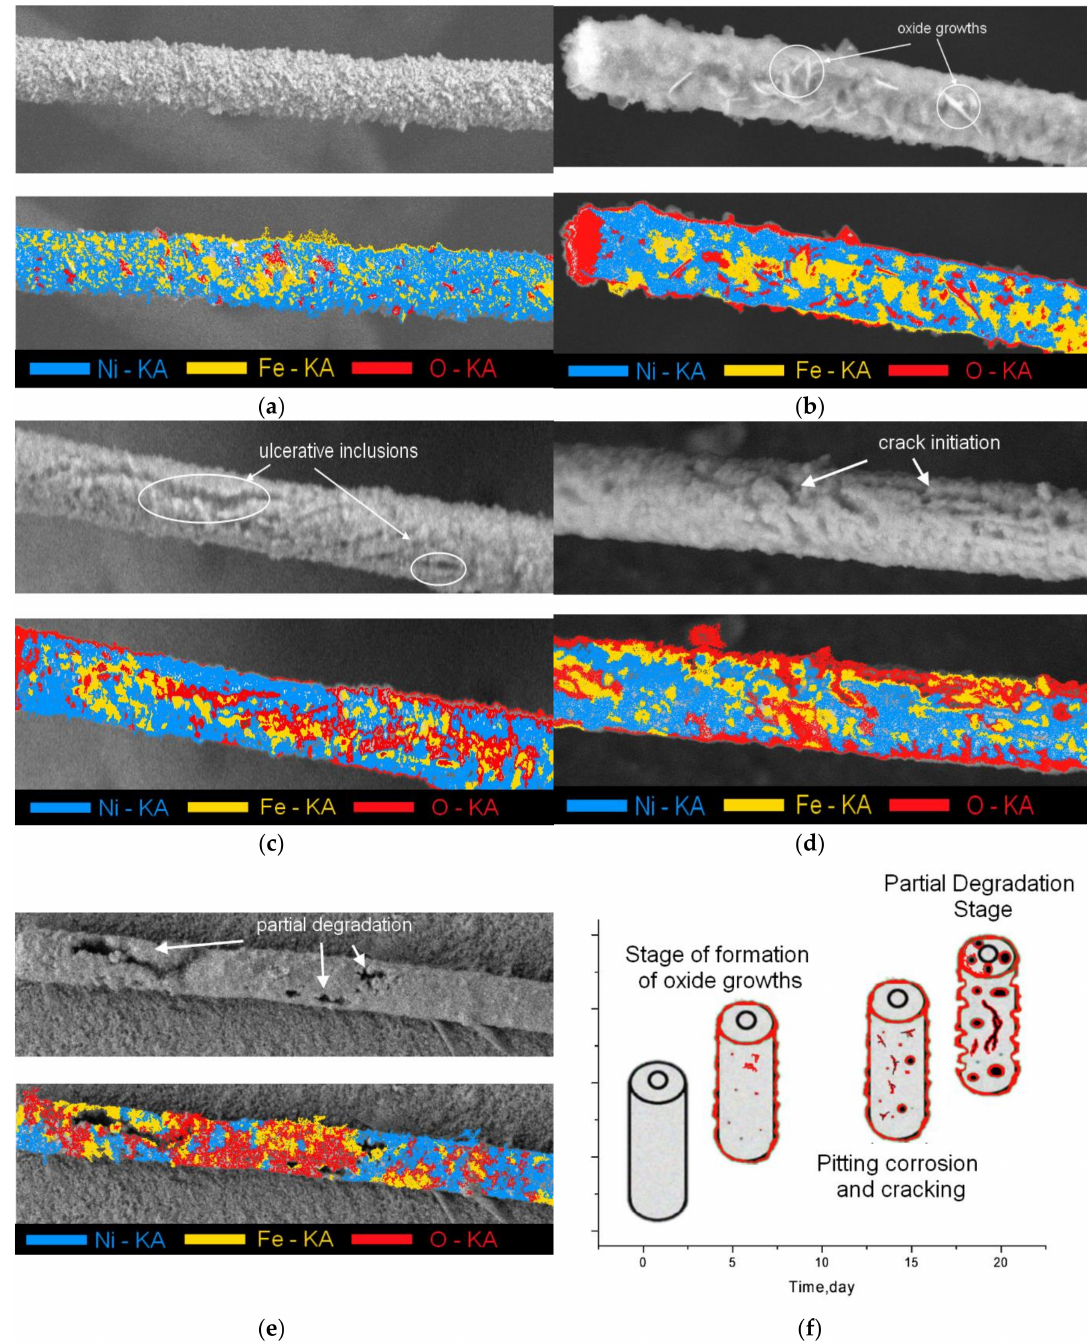
Figure 6. SEM images of the stages of degradation of nanostructures irradiated with a dose of 500 kGy: ( a ) 3 days of testing; ( b ) 5 days of testing; ( c ) 10 days of testing; ( d ) 15 days of testing; ( e ) 20 days of testing. ( f ) Diagram of degradation of irradiated